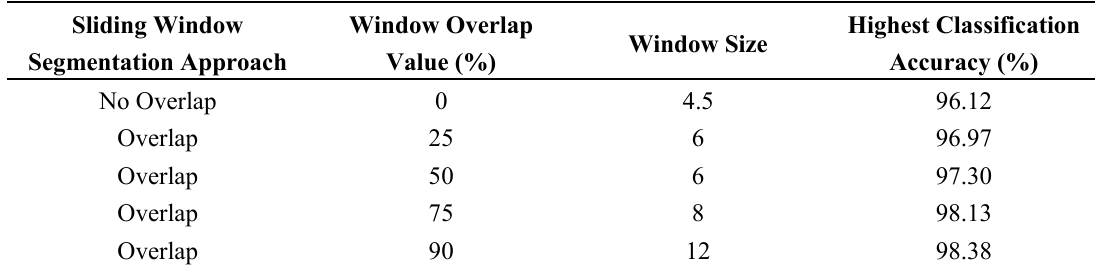
Table 5. The highest accuracies for window overlap and window size combinations using SVM classifiers.